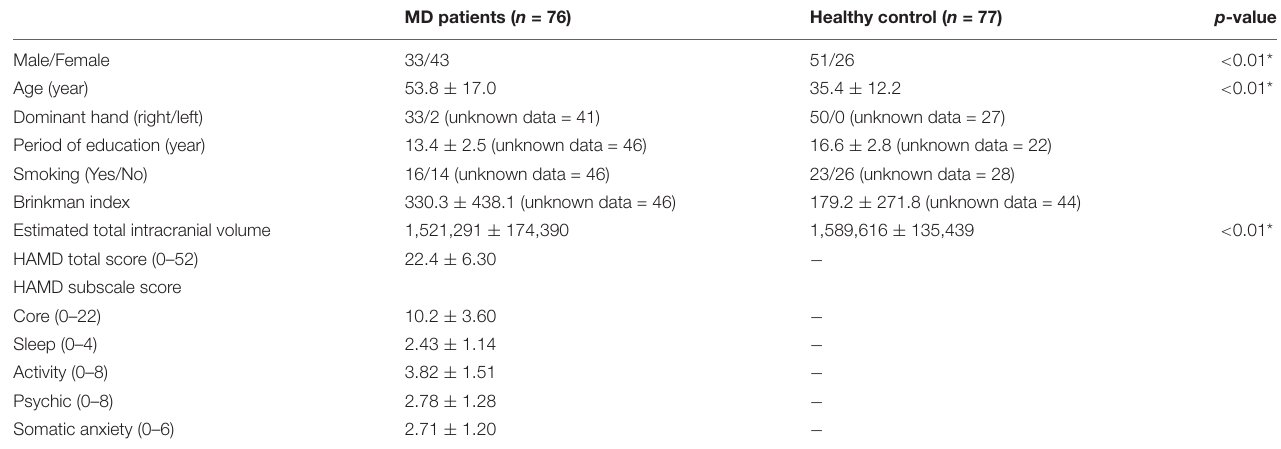
TABLE 1 | Background factors in MD patients and healthy